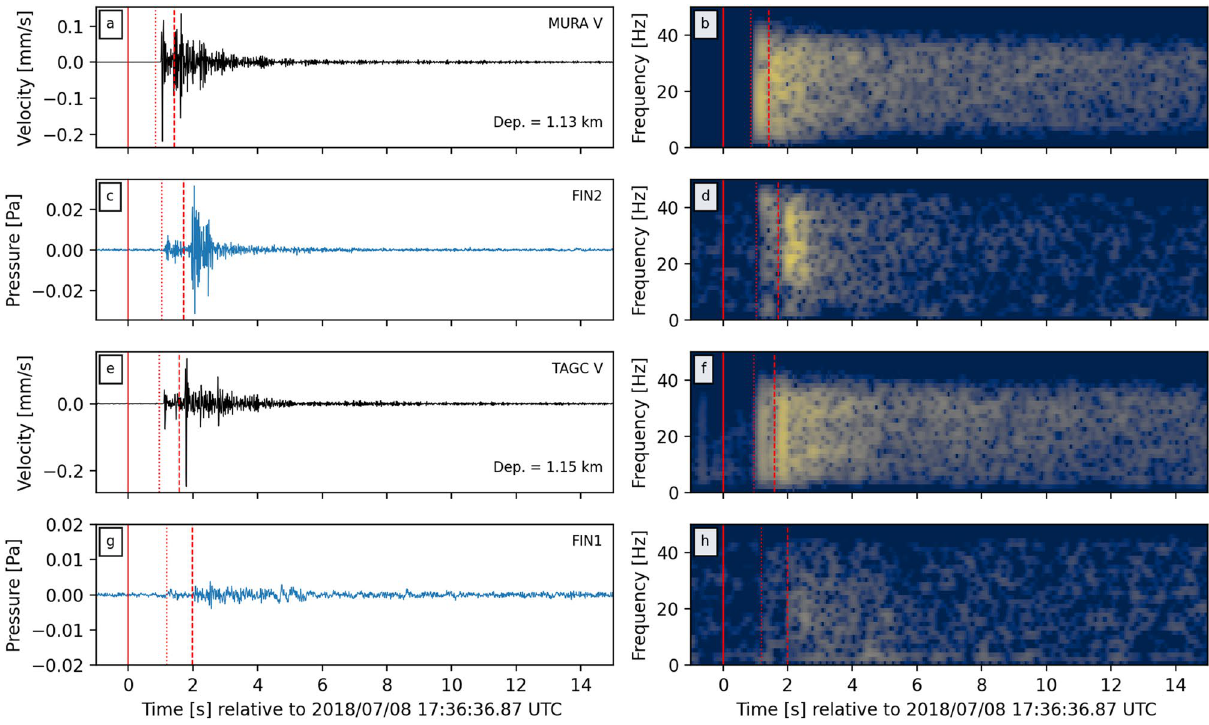
Figure 3. Filtered waveforms (left column) and their respective frequency spectrograms (right column) of the M w 1.87 event as recorded by seismic station MURA ( a , b ), acoustic array FIN2 ( c , d ), seismic station TAGC ( e , f ) and acoustic array FIN1 ( g , h ). Note that the seismic waveforms are from the vertical component of the station. Spectrograms were calculated with 0.5 s windows with 90% overlap. Also plotted is the time of the event (solid red line), as well as predicted arrival times for P- and S-wave phases (dotted and dashed red lines, respectively) from source locations to each station or array.